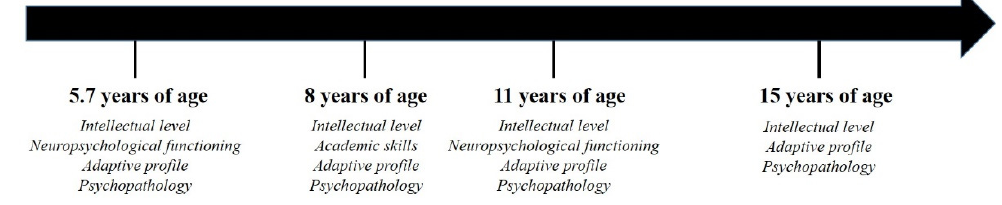
9 of 21 Figure 3. Homology Modeling of the CSMD1 variants. Top: multiple sequence alignment of CSMD1